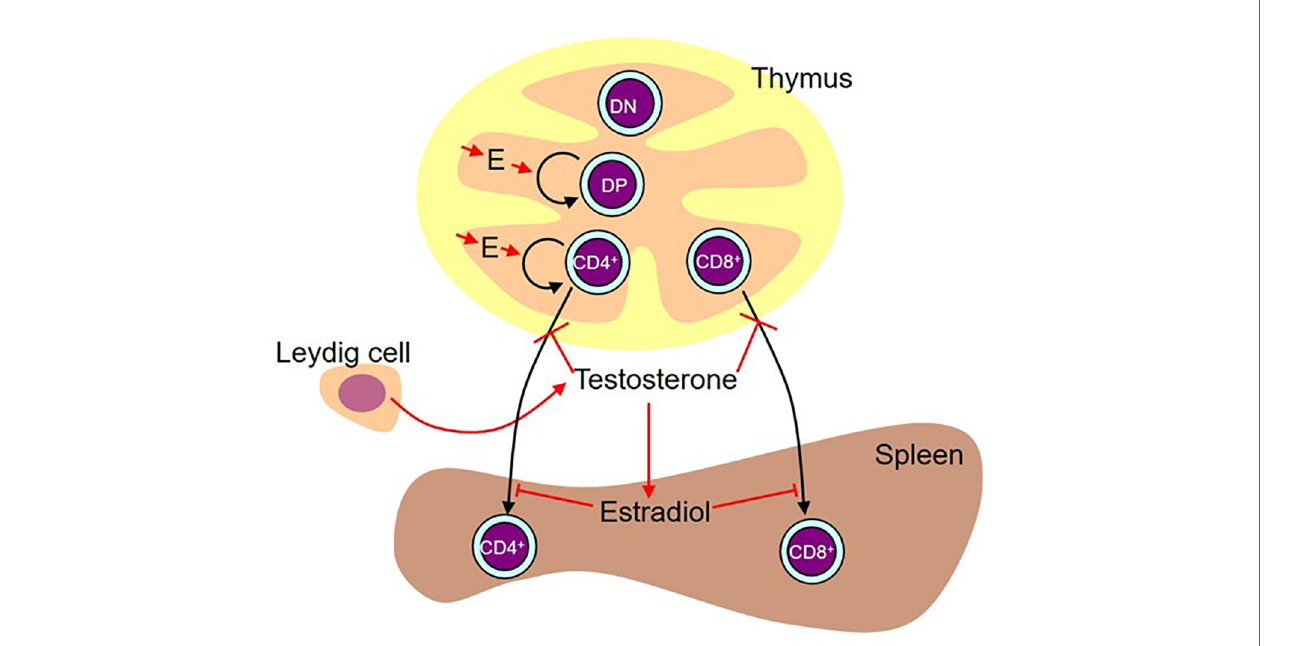
FIGURE 13 | Working diagram illustrating the results. Estradiol (E) produced by the thymic epithelium/stroma stimulates proliferation of double positive (DP) and CD4 single positive cells. While administered testosterone (presumably aromatized to estradiol) and estradiol also had a stimulatory effect on double negative (DN) and CD8 single positive cell number, we are basing the preference for stimulation of the pathway leading to the production of CD4+ cells on the fl utamide and letrozole results on the assumption that these results are more likely representative of the effect of physiological levels of locally produced steroids. In males, there is a peripartum surge of testosterone produced by the Leydig cells in the testes. This testosterone inhibits release of mature cells from the thymus. This activity is testosterone-speci fi c (i.e. it is not aromatized). In the spleen, some of this testosterone is aromatized to estradiol, which in turn inhibits T cell seeding of the